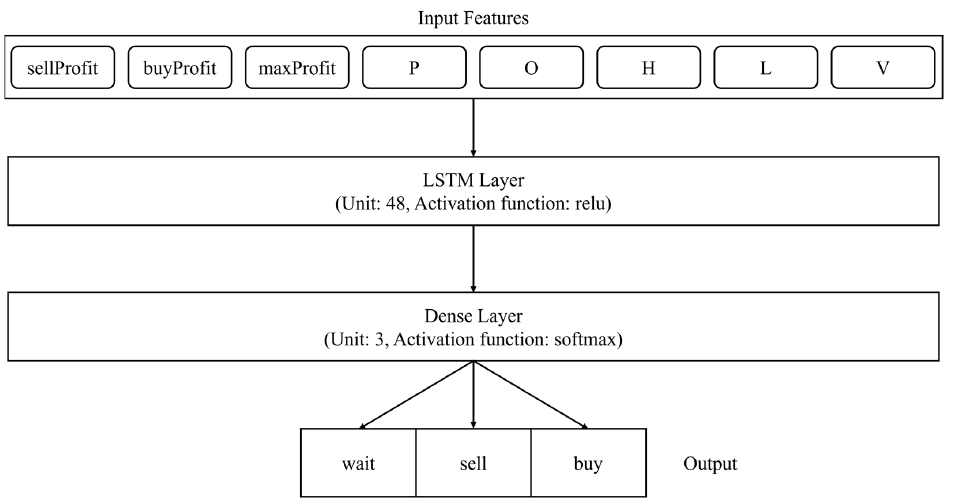
Figure 6. Price fluctuation graph of 6 major cryptocurrencies per each day. ( a ) Bitcoin; ( b ) Cardano; ( c ) Dash; ( d ) Ethereum; ( e ) Litecoin; ( f ) Monero.